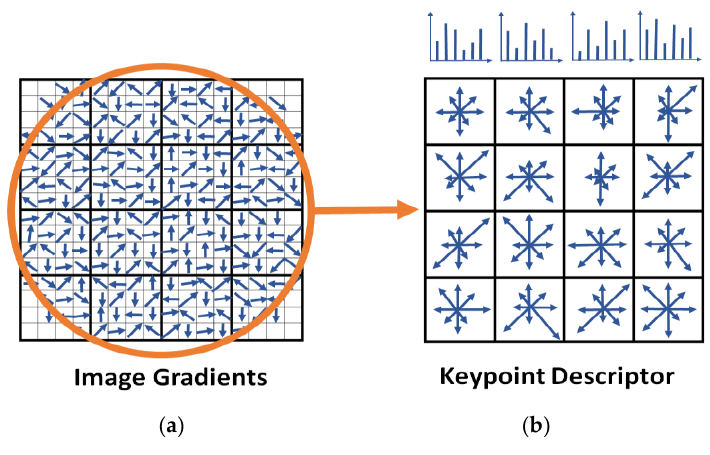
( b ) Figure 15. ( a ) Gradient magnitude and orientation of a key point; ( b ) gradient magnitude and orientation of all key points found. (d) Key Point Description